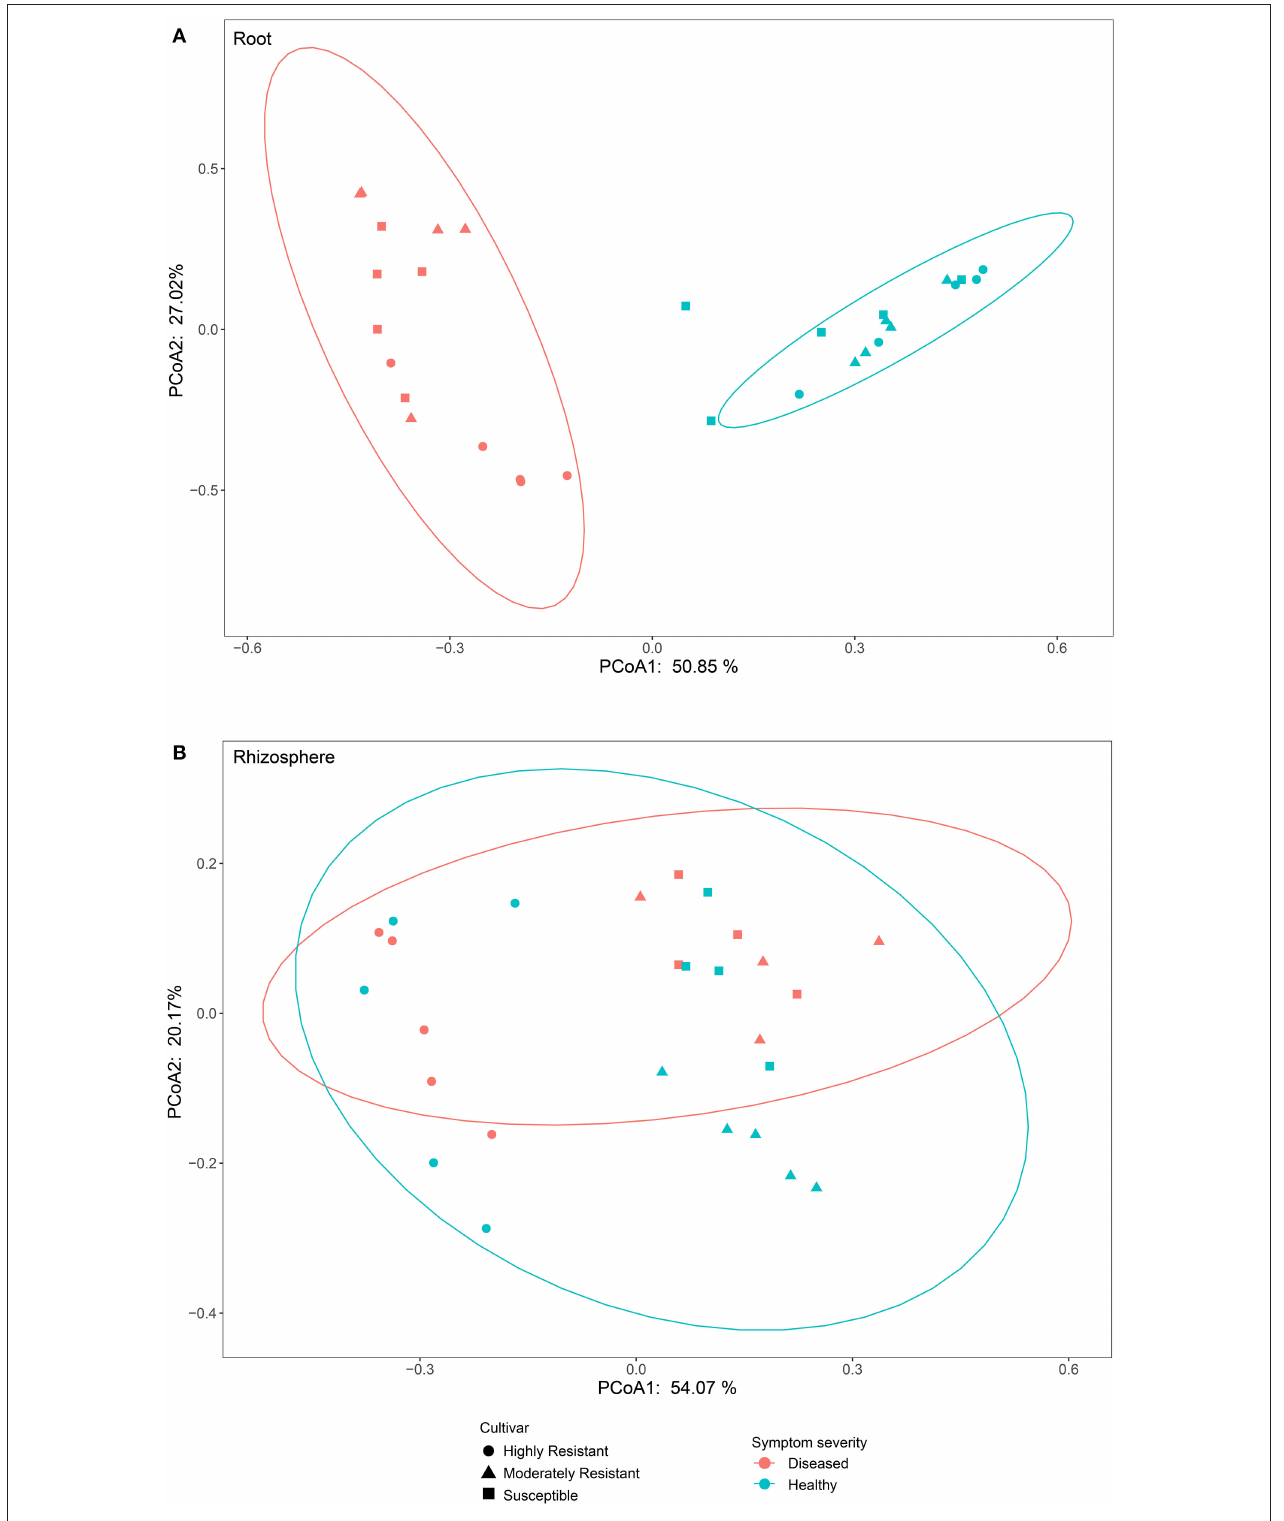
FIGURE 4 | Bray-Curtis matrices visualized using principle coordinates analysis (PCoA) showing distribution of samples according to symptom severity (Diseased and Healthy) and host genotype (Highly resistant, Moderately resistant, and Susceptible cultivars) in roots and rhizosphere soil.